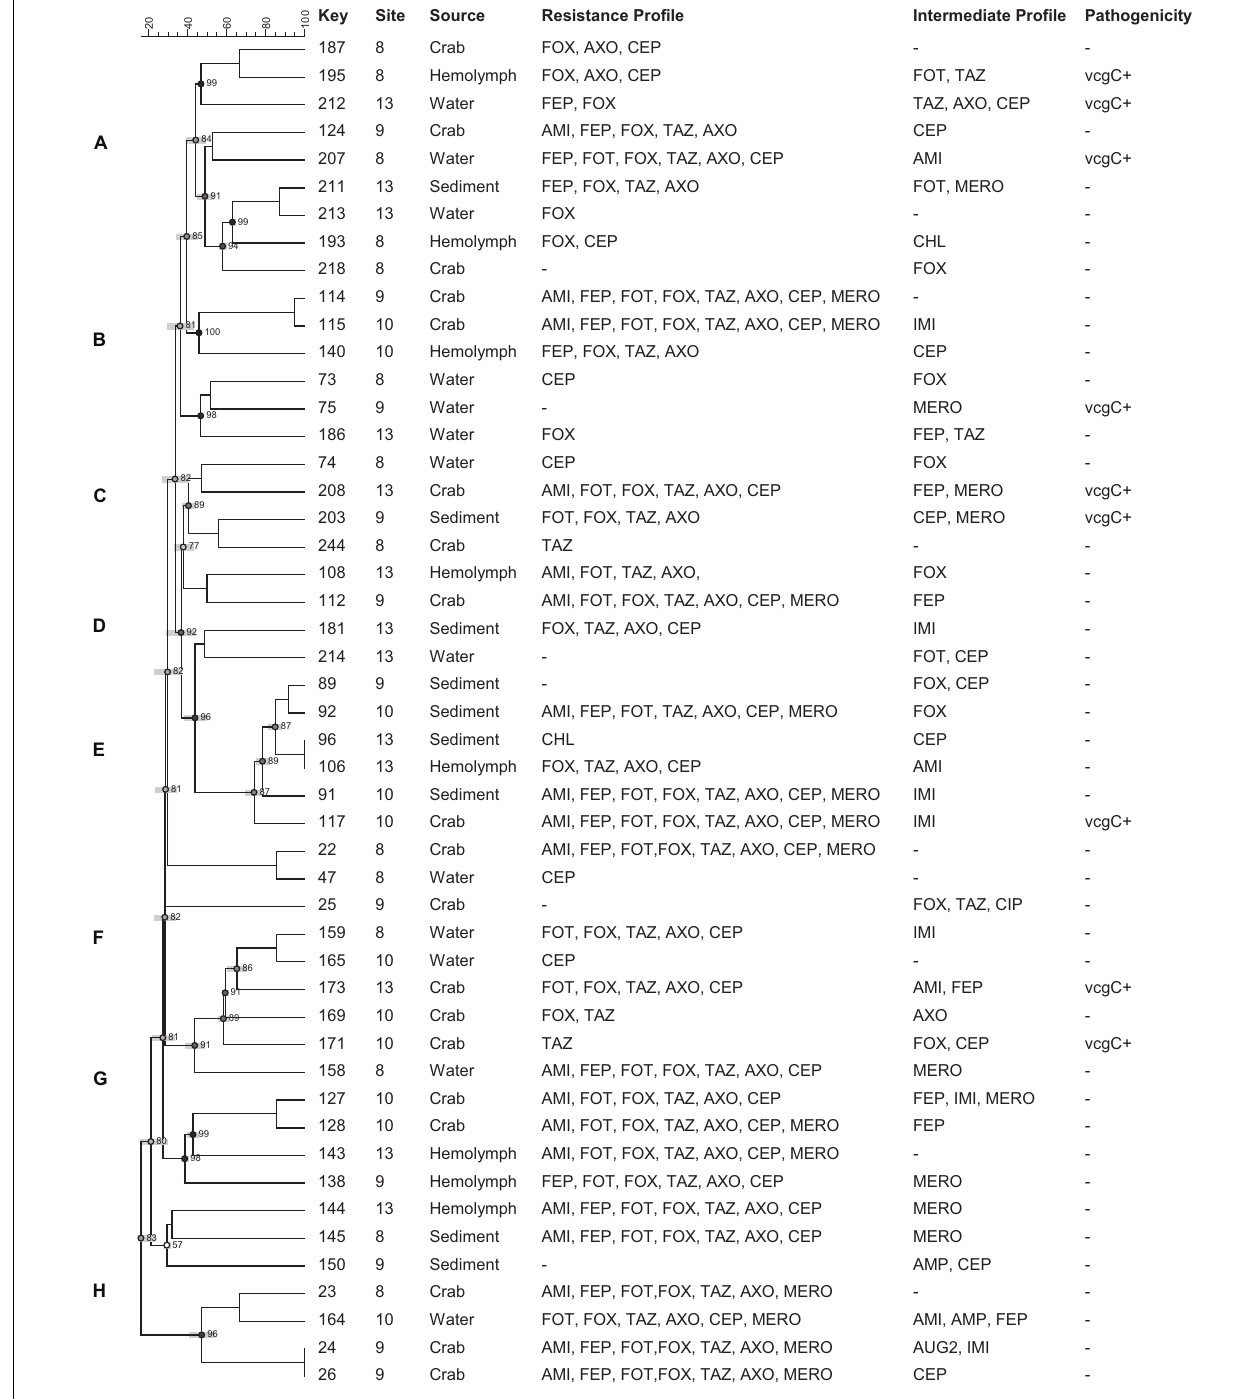
FIGURE 4 | Dendrogram of PFGE profiles of Vibrio vulnificus strains collected form crab and its environment in Maryland Coastal Bays; Site 8- Chincoteague Bay, 9- Newport Bay, 10- Sinepuxent Bay, 13–St. Martin River. Key = stain number. AMI, amikacin; AUG2, amoxicillin/clavulanic acid; AMP, ampicillin; A/S2 ampicillin-sulbactam; FEP, cefepime; FOT, cefotaxime; FOX, cefoxitin; TAZ, ceftazidime; AXO, ceftriaxone; CEP, cephalothin; CIP, ciprofloxacin; CHL, chloramphenicol; DOX, doxycycline; IMI, imipenem; LEVO, levofloxacin; MERO, meropenem; PIP, piperacillin; P/T4, piperacillin/tazobactam; TET, tetracycline; SXT, trimethoprim/sulfamethoxazole. vcgC , virulence-correlating gene type C. Letters A to H on the left represent pulsed-field gel electrophoresis clusters; key represent strain numbers. Minus sign on the resistance and intermediate profiles columns indicate “no resistance” or “no intermediate” profiles and on the Pathogenicity column (-) mean vcgC gene